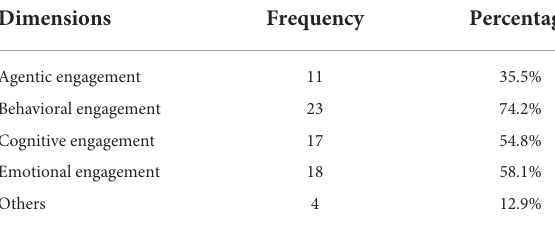
TABLE 9 Dimensions of student engagement studies